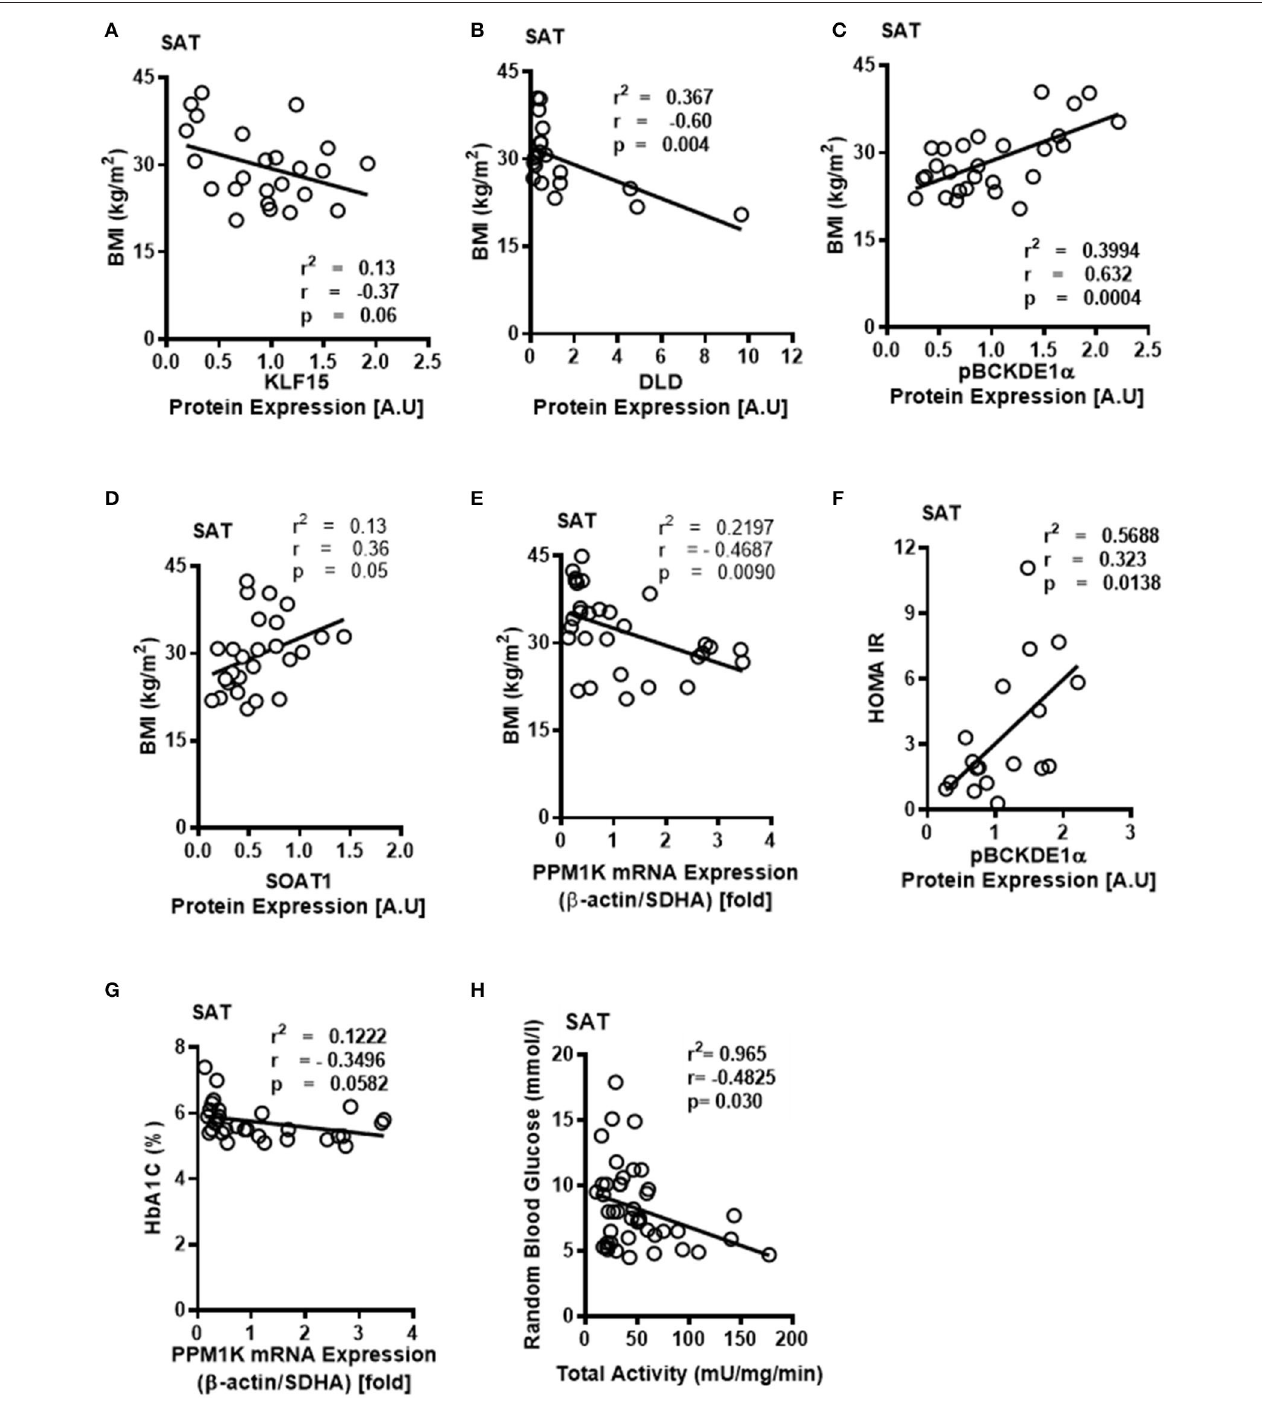
FIGURE 3 | Downregulated BCKDH enzyme activity and expression of BCAA catabolic enzymes in the SAT of obese patients are associated with BMI and markers of insulin resistance. Linear regression of (A) KLF15, (B) DLD, (C) phosphorylated BCKDE1a, (D) SOAT1 protein expression in the SAT of non-obese ( n = 7), pre-obese ( n = 7), class I obese ( n = 8) and class II obese ( n = 6) cardiac surgery patients and (E) PP1MK mRNA expression in the SAT of non-obese ( n = 6), pre-obese ( n = 6), class I obese ( n = 6), class II obese ( n = 6) and class III obese ( n = 6) cardiac surgery patients correlated with BMI. Linear regression of (F) pBCKDE1 α protein levels in the SAT of non-obese ( n = 7), pre-obese ( n = 7), class I obese ( n = 8) and class II obese ( n = 6), (G) PP1MK mRNA levels in the SAT of non-obese ( n = 6), pre-obese ( n = 6), class I obese ( n = 6), class II obese ( n = 6) and class III obese ( n = 6) and (H) Total BCKDH enzyme activity in the SAT of non-obese ( n = 7), pre-obese ( n = 9), class I obese ( n = 9), class II obese ( n = 9) and class III obese ( n = 8) correlated with HOMA-IR,HbA1c% and random blood glucose levels, respectively, in the SAT of cardiac surgery patients. Statistical analysis was performed using one-way ANOVA; followed by a Tukey’s multiple comparison test; p < 0.05 was considered